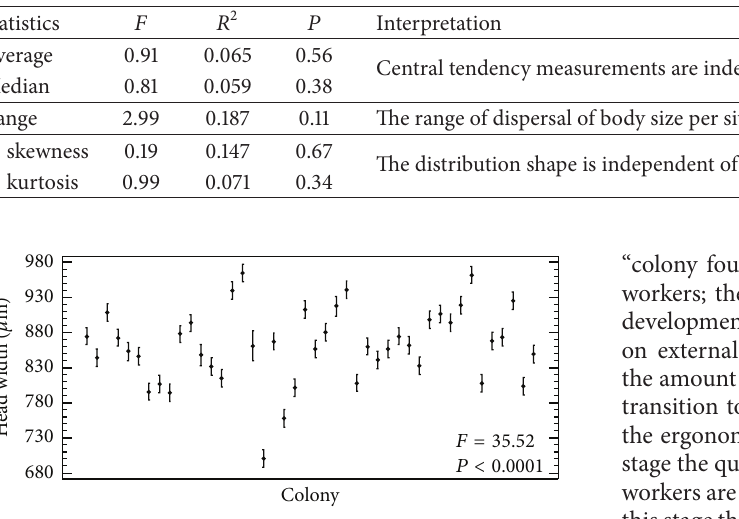
Figure 1: The results of one-way ANOVA of head size of the ant Lasius niger collected from 44 colonies. Points represent the mean value calculated per colony. Whiskers denote 95% intervals of LSD test. Since 𝑃 < 0.0001 , the colonies differ significantly in average head size of